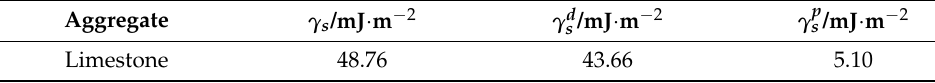
Table 1. Surface energy parameters of limestone.